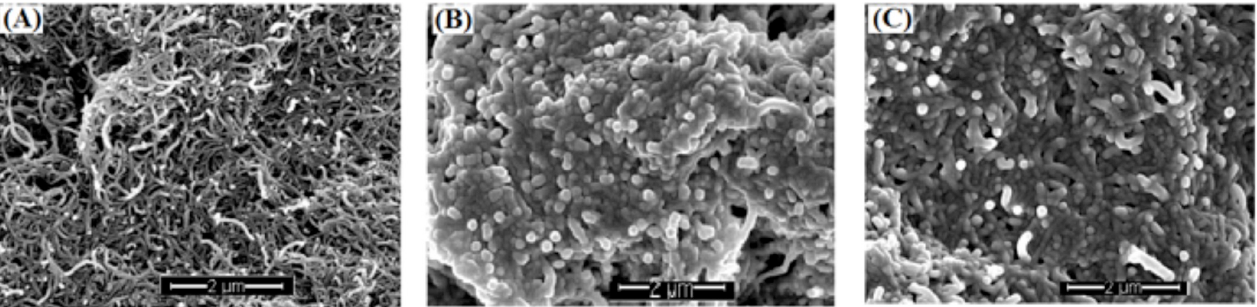
Fig 2. Representative SEM images of surfaces of (A) MWCNTs filter, (B) LEO-MWCNTs filter, and (C) TTO-MWCNTs filter.